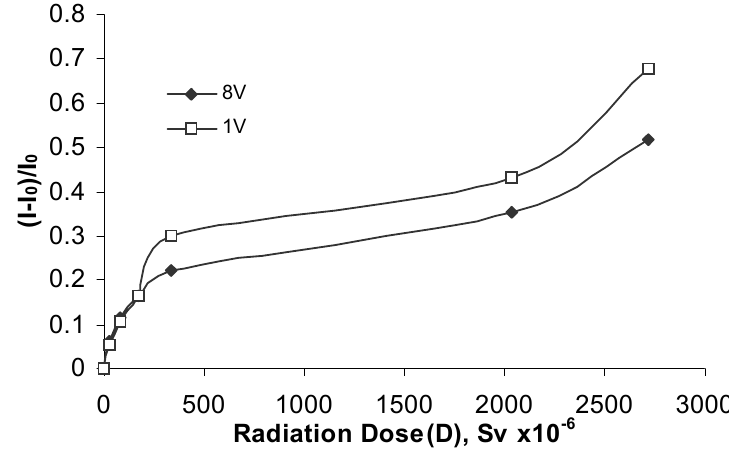
Figure 9. Plots of normalised current (I-I and 8 V for 0.1 wt.% Carbon-filled NiO planar structures.